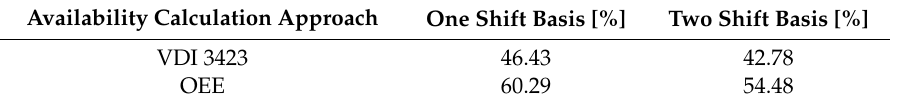
Table 5. Comparison of an availability calculation from a production facility of an OBerA consortium.